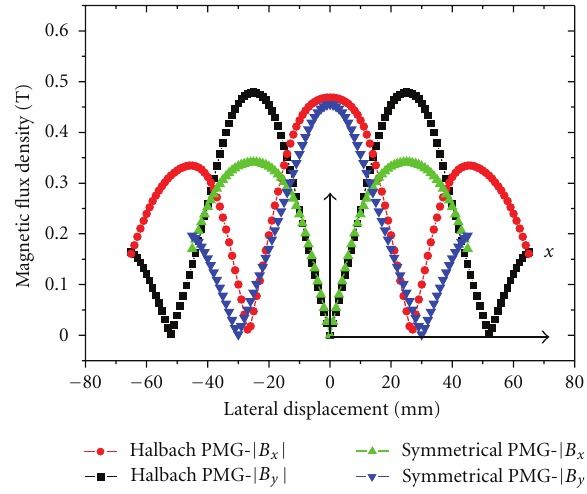
Figure 3: The magnetic flux density distribution of Halbach PMG symmetrical